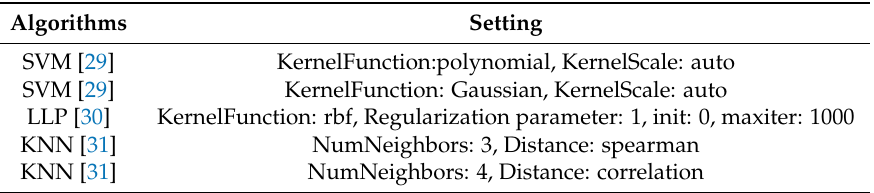
Table 2. Classification algorithms and related